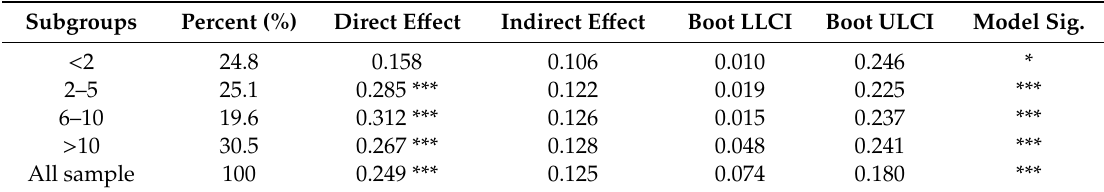
Table 8. Non-standardized results of subgroup analysis of work experience by SPSS